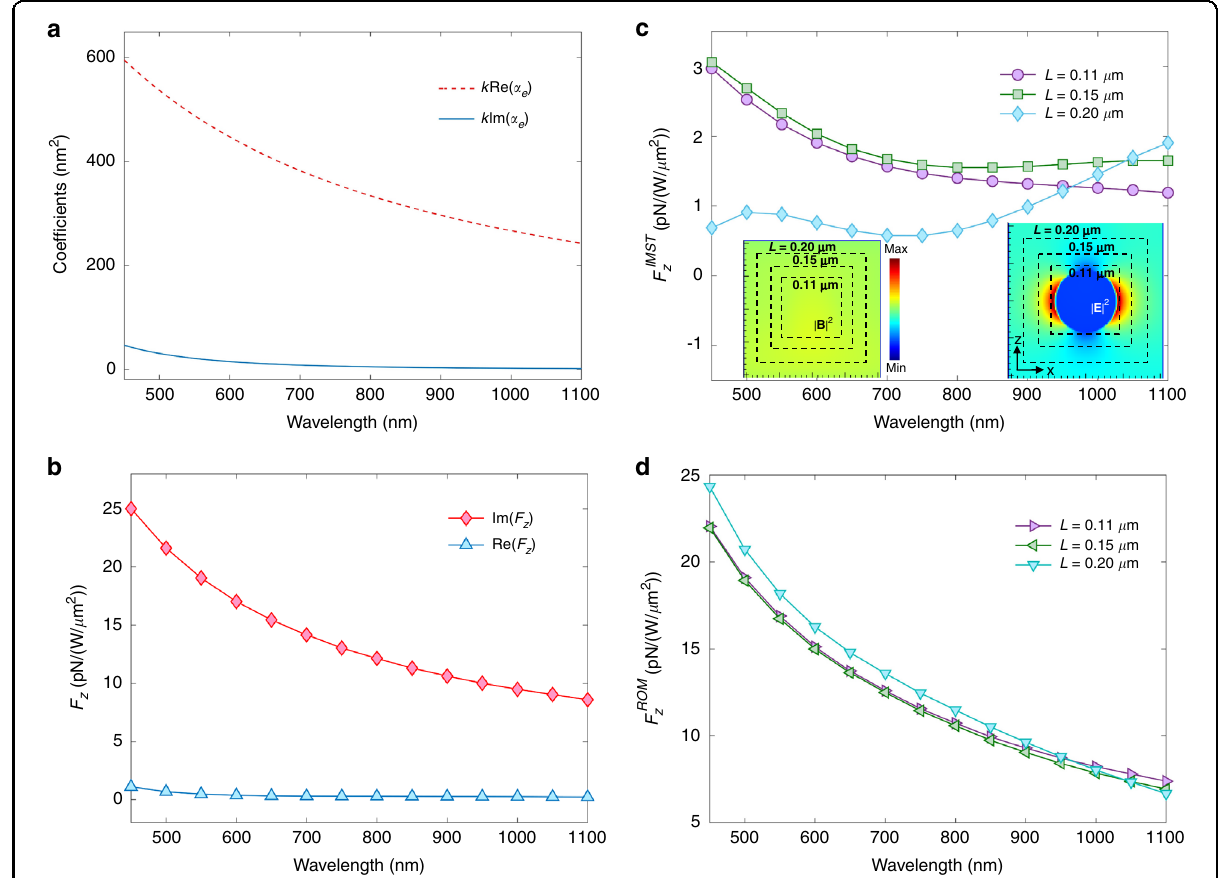
Fig. 2 Linearly polarized propagating plane wave incident on a polystyrene sphere of radius a = 50 nm and refractive index n PS = 1.59. a Polarizability calculated via Mie theory. b Numerical results, per unit of incident power density, E 0 = 1, for the ILF F I , of F I , calculated with different cube integration contours. Insets show the spatial distribution on the x = 0 plane of the electric and component, F IMST z z magnetic fi eld intensities in and around the sphere excited at λ = 800 nm. White broken line squares illustrate the integration contours. d ROM , of the ILF, calculated by subtracting F IMST from F I component, F ROM z z